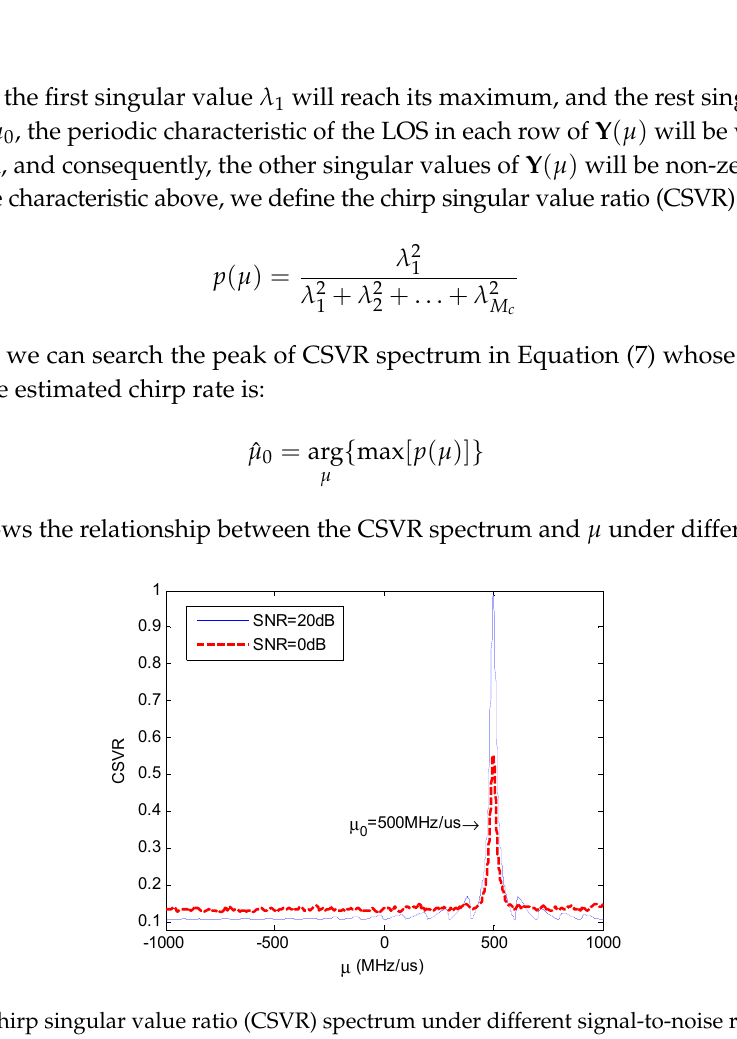
Figure 3. Chirp singular value ratio (CSVR) spectrum under different signal-to-noise ratio (SNR).